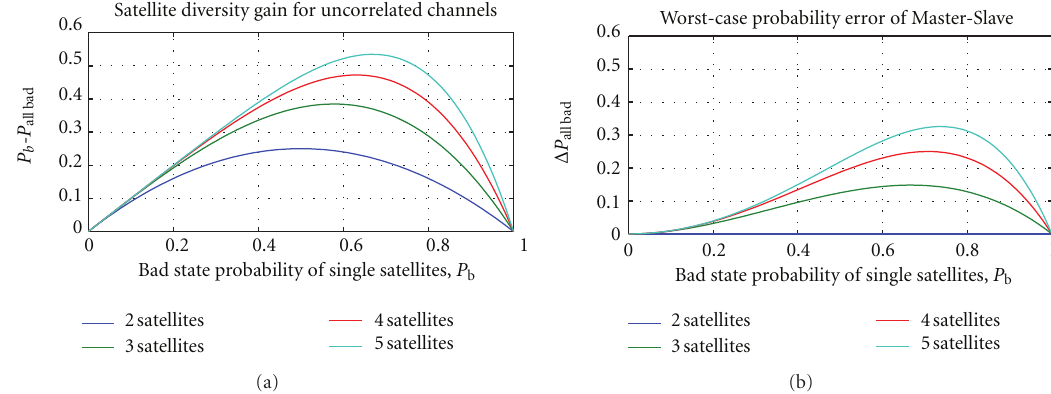
Figure 14: (a) Satellite diversity gain of uncorrelated satellites with dependency on the bad state probability of the individual satellites P b , and the number of satellites k . It represents the improvement of a system with k uncorrelated channels to a system with one channel. (b) Worst-case probability error of the Master-Slave approach (constellations from Figure 13) with dependency on the bad state probability of the individual satellites, and the number of satellites (it is k uncorrelated channels minus 2 uncorrelated channels).